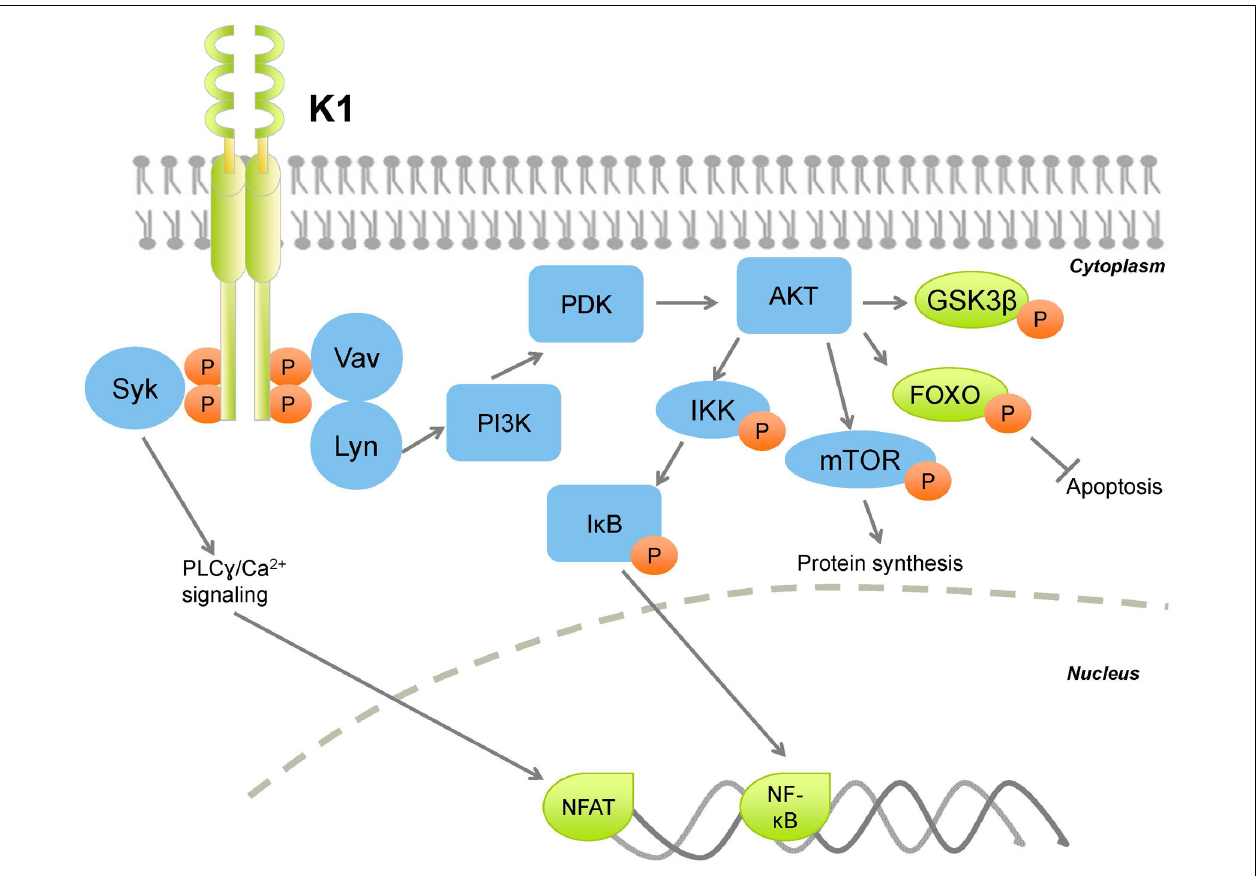
FIGURE 1 | Kaposi sarcoma-associated herpesvirus K1 activates PI3K/AKT/mTOR signaling thereby activating protein synthesis and survival pathways, while inhibiting apoptotic pathways. Orange circles denote